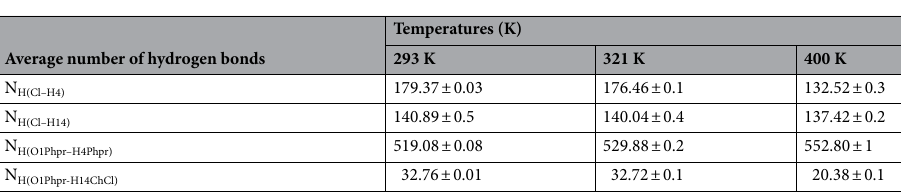
Average number of hydrogen